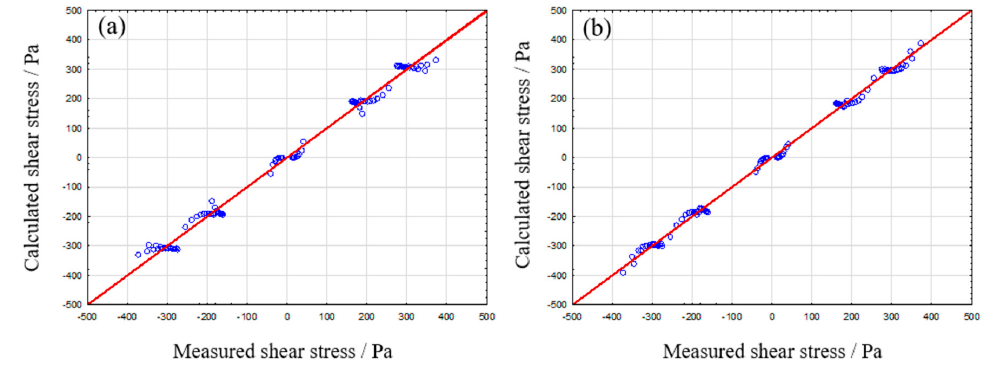
Figure 8. Measured shear stress against calculated shear stress for Kelvin–Voigt ( a ) and Zener m / k ( b ).